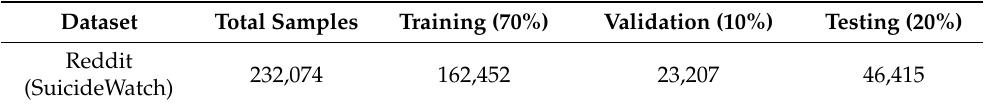
Table 2. Dataset splitting.